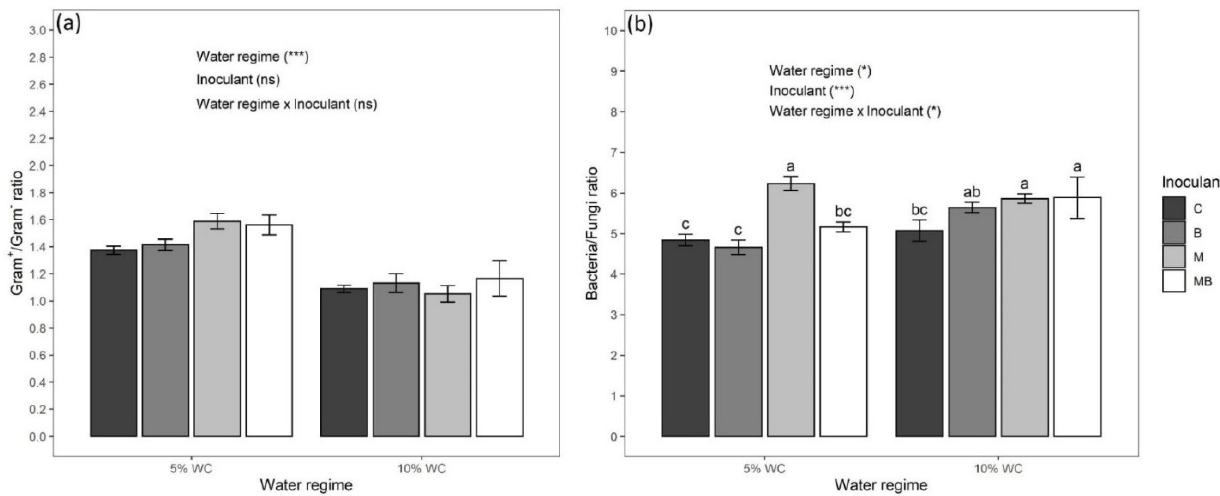
Figure 3. Mean ( ± SE) Gram + /Gram − ( a ) and bacteria/fungi ( b ) ratios in soil samples of Lactuca sativa under different water regimes. In the case of significant effects (* p < 0.05, *** p < 0.001), the results of the post hoc comparisons are presented. The significant effect of “inoculant type × water regime” is presented by the letters above the bars; bars topped by the same letter do not differ significantly (C = Control, B = B. subtilis , M = AMF, MB = AMF and B. subtilis ).